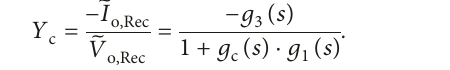
Table 2: Specifications of operating point and control parameters. Low-voltage DC, V